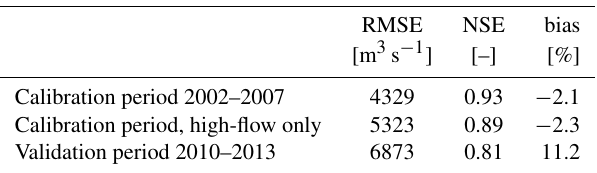
Table 3. Performance criteria for simulated discharge Q sim at Ba- hadurabad station. Bias is given as (Q sim − Q obs )/Q sim . RMSE NSE